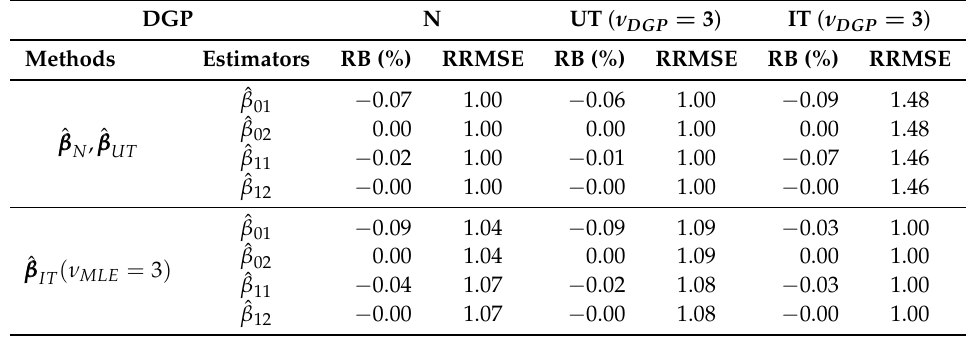
, ˆ βββ , ˆ βββ ) for the N UT IT